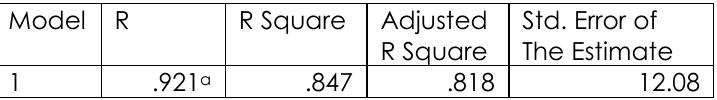
Tabel 5. UJi dan Analisis Model Summary Multiple